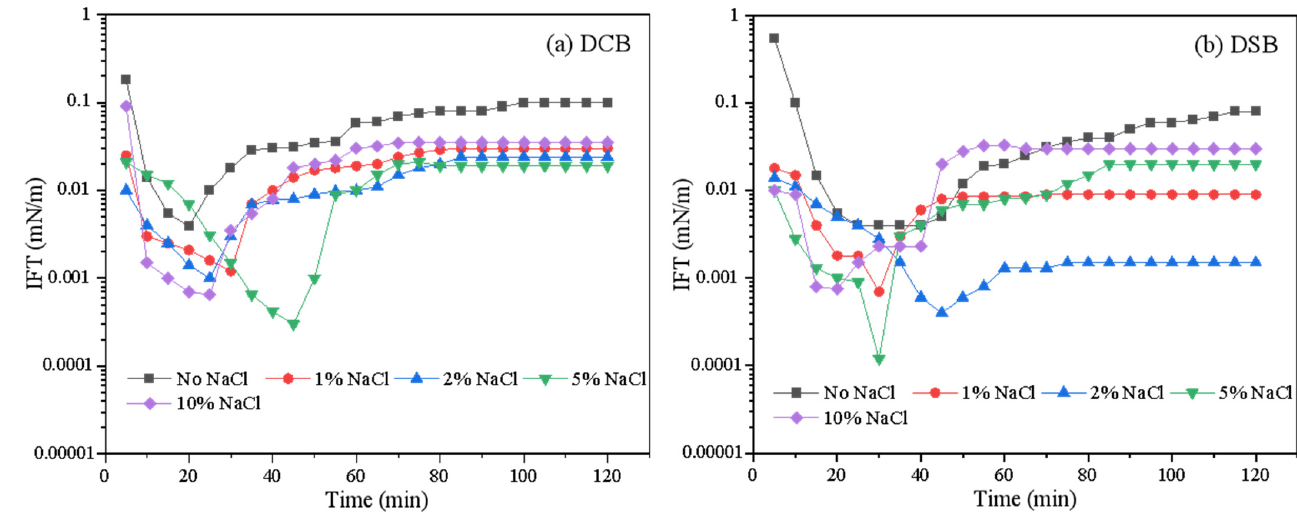
Figure 5. Effects of sodium chloride on IFT between the optimum concentrations of surfactants and Xinjiang crude oil at 40 °C for DCB ( a ) and DSB ( b ).